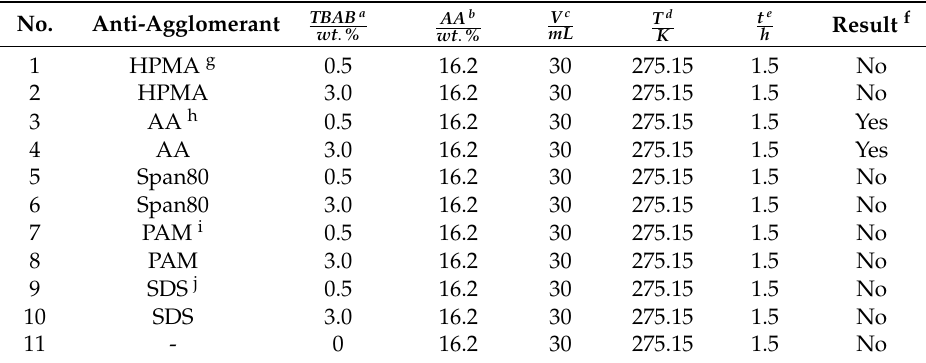
Table 1. Results of anti-agglomerant screening.